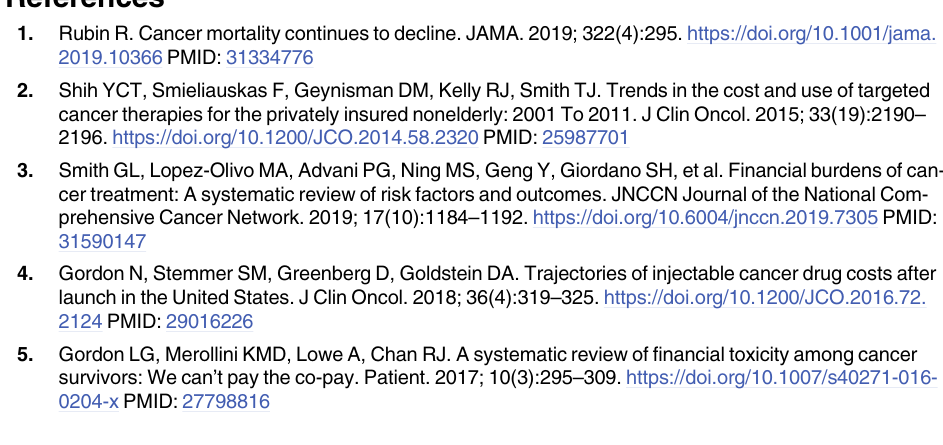
S2 Table. Basic demographic and clinical information for 515 included patients. S3 Table. Revised